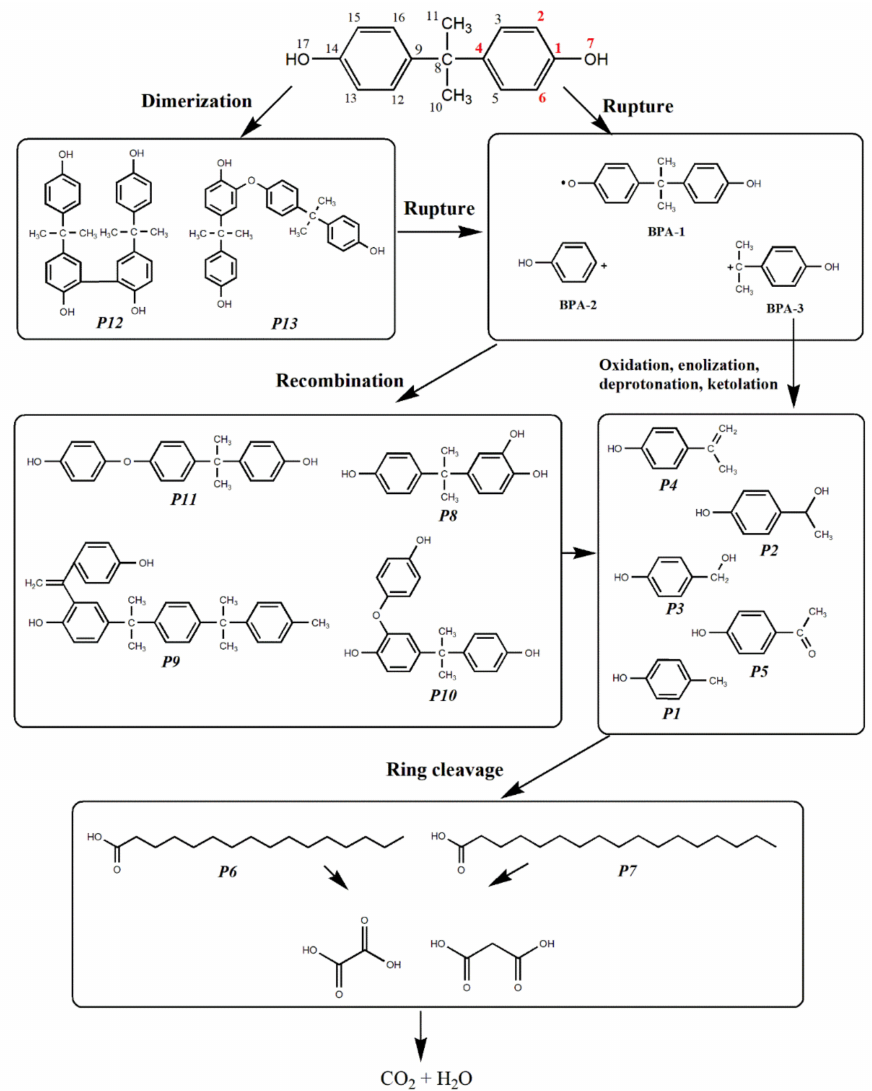
Figure 7. Proposed main BPA degradation pathways with steps leading to the intermediates identi- fied using GC-MS (Table S2) under the MnO 2 /UV/PS